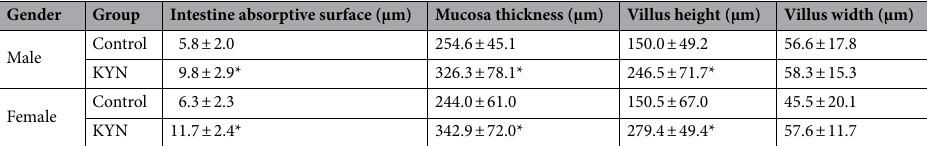
Table 2. Effect of kynurenine administration during maternal feeding on histomorphometric parameters of jejunum of 22-day old rats. Data are presented as a mean ± SEM, number of subjects in each group = 10, *P < 0.05 vs respective Control, t -Student test. KYN